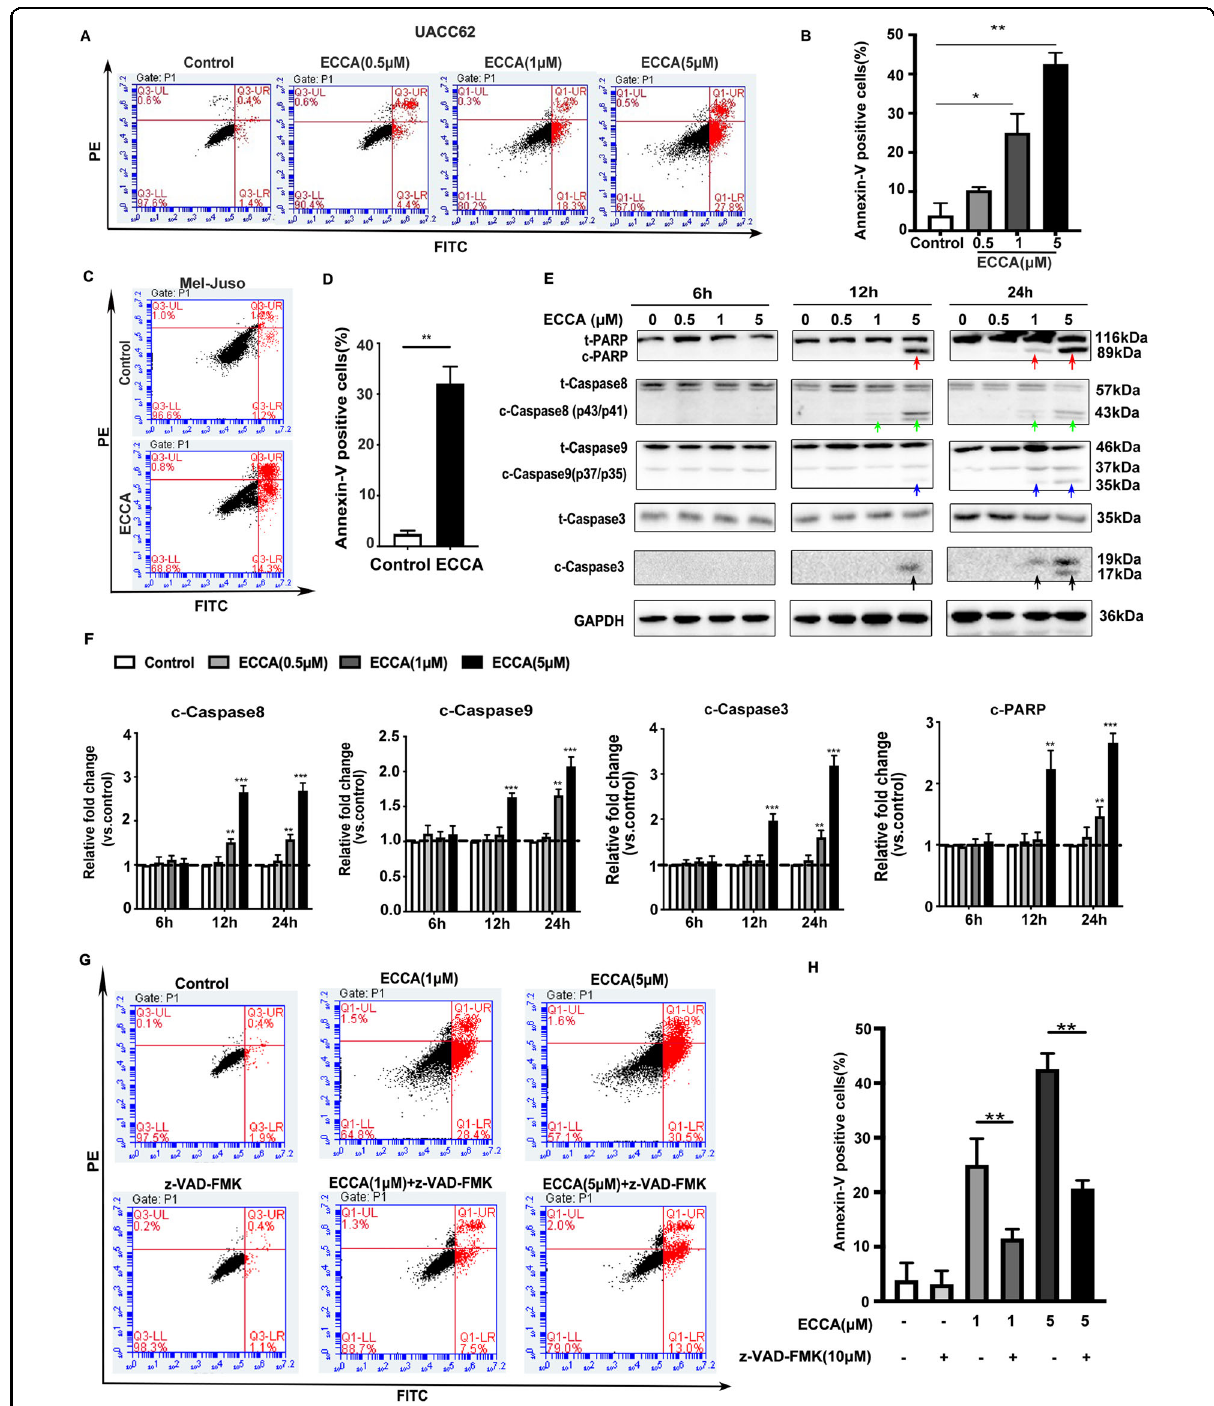
Fig. 2 (See legend on next